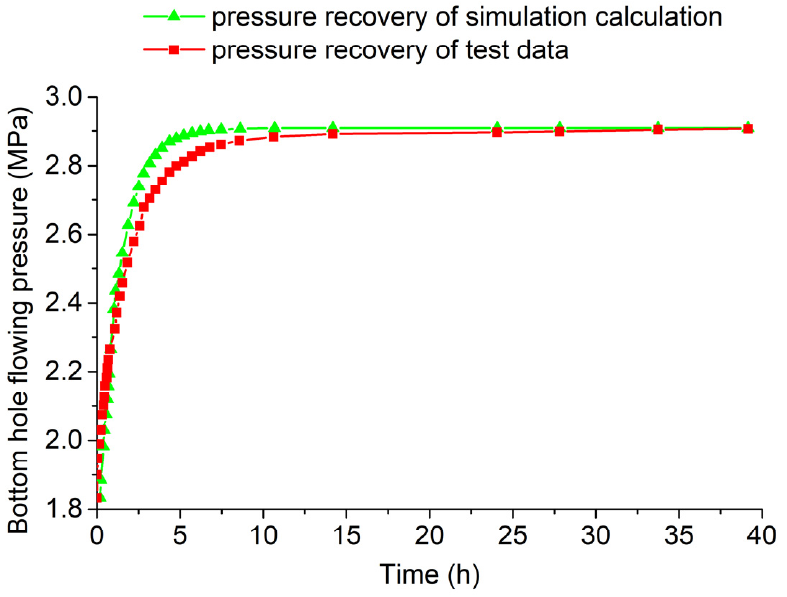
Table 7. Error analysis of the results of pressure recovery simulation calculation and test data.